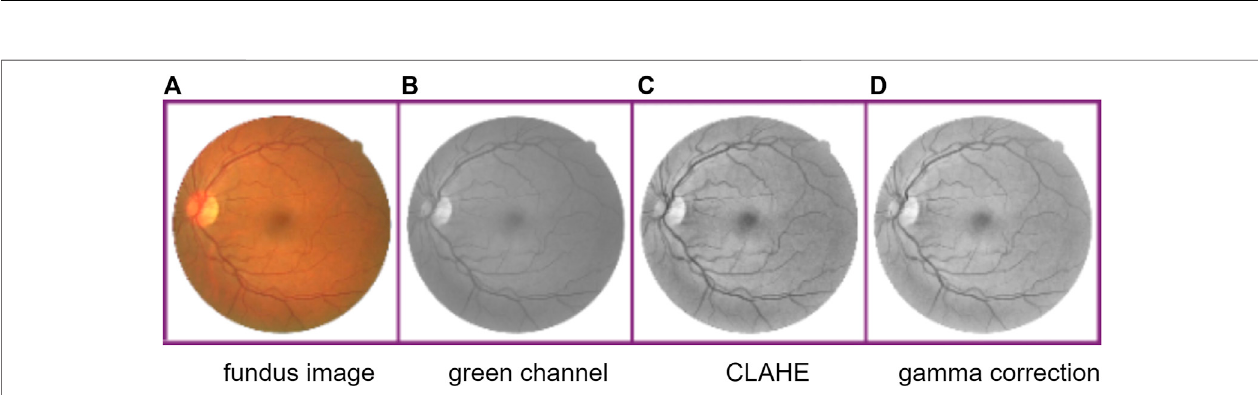
FIGURE3| Processofimagepreprocessing.Fromthelefttoright:fundusretinaimage,imageofgreenchannel,CLAHE-processedimage,andgammacorrection processed image.